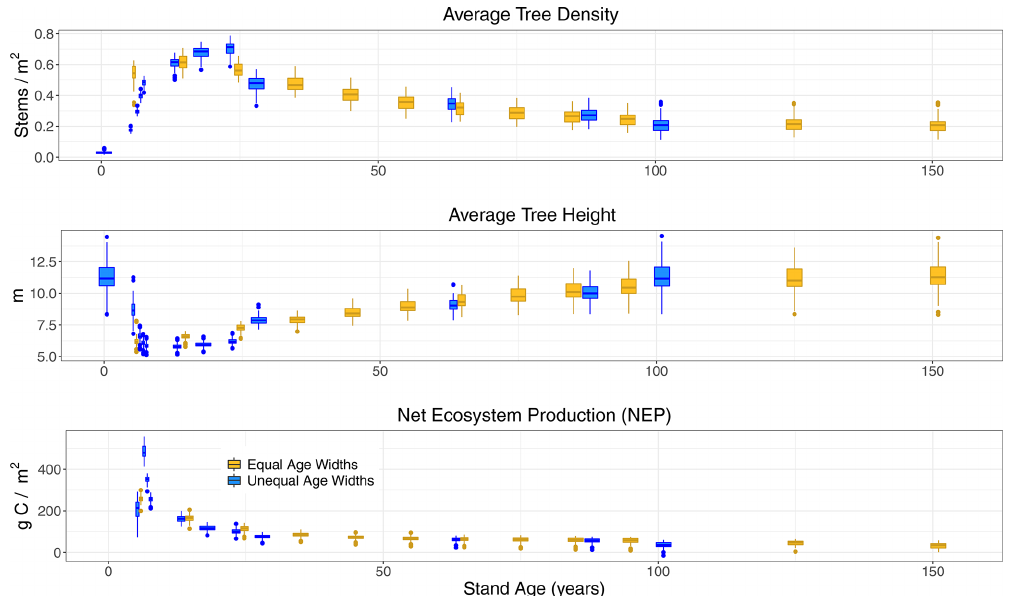
Figure 3. Boxplots by age classes ( x axis, in years) from LPJ-wsl v2.0 simulations for US states of MI, MN, and WI. Data are from (yellow) simulations using equal age widths and (blue) simulations using and unequal age widths (see Table 1). Data are plotted on the x axis at the middle age of the age-class bin; note that the last age-class bin for either simulation is defined as + 151 years (equal bin) and + 101 years (unequal bin). For average tree height (middle row), large tree heights in the youngest age class of the unequal-bin simulation (blue) represent so-called “survivor” trees.